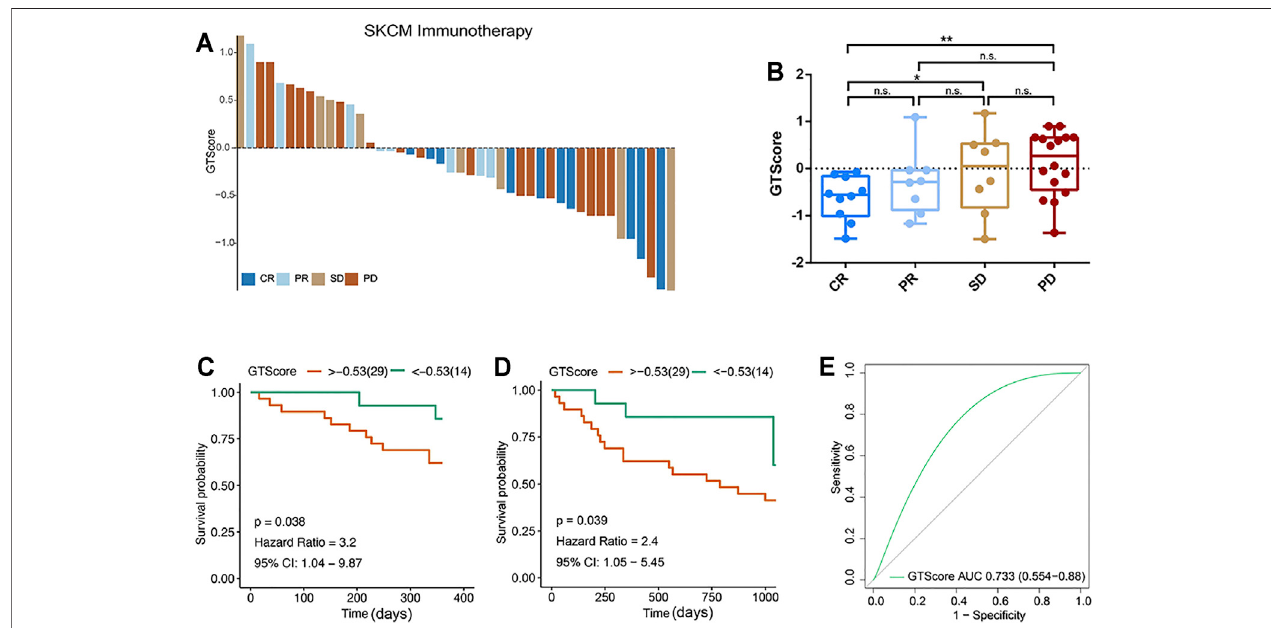
FIGURE 9 | GTscore as a predictive indicator of the response to immunotherapy of melanoma. (A) Waterfall plot showing the GTscore and corresponding immunotherapy ef fi cacy of individual patients. (B) Boxplot showing the distribution of GTscore in groups with different anti – PD-1 clinical response statuses. GTscore predicting the1-year (C) and 3-year (D) OSrateofpatients receivinganti – PD-1immunotherapy via Kaplan – Meier curves. (E) Thepredictive valueofGTscore in patients receiving anti – PD-1 immunotherapy via ROC curve analysis. * p < 0.05, ** p < 0.01.